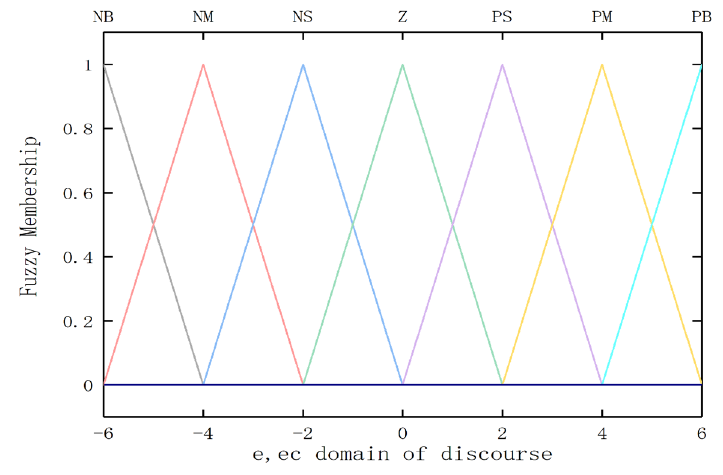
Figure 5. Plot of the error and the affiliation function for the rate of change of the error.